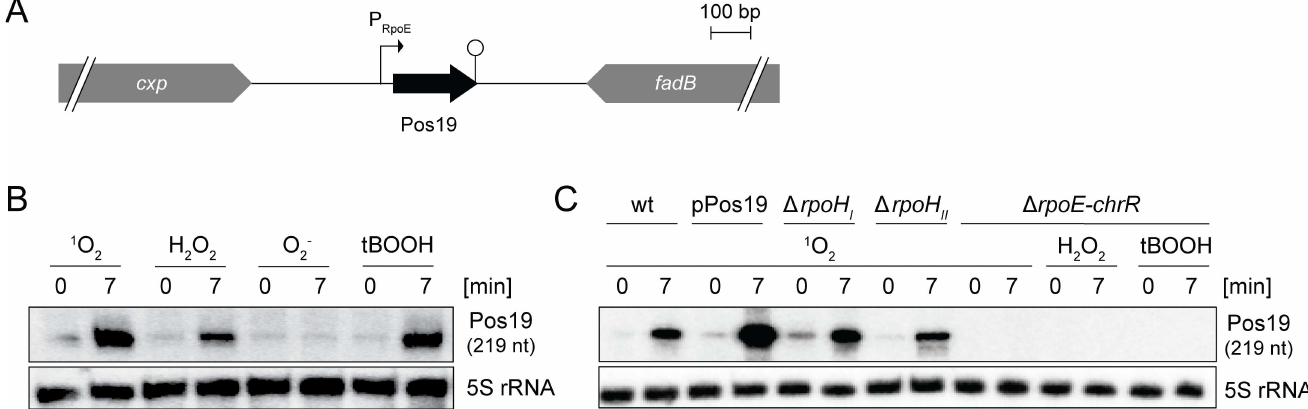
Fig 1. Pos19 is induced by singlet oxygen and peroxides. (A) Graphical representation of the Pos19 locus in R . sphaeroides wild-type strain 2.4.1. The pos19 gene is located on chromosome 2 between cxp and fadB . The conserved RpoE-dependent promoter (P RpoE ) and the Rho-independent terminator (lollipopstructure) are indicated. (B) Northern blot for stress-dependent Pos19 induction. R . sphaeroides wild-type 2.4.1 cultures were treated with stress-generating chemicals and samples collectedat time points 0 and 7 min. Singlet oxygen ( 1 O 2 ) was generated by the additionof 0.2 μ M methylene blue in the presence of high light intensities (800 W m -2 ). Hydrogenperoxide (H 2 O 2 ) and tert -butyl hydroperoxide (tBOOH) were added in final concentrations of 1 mM and 300 μ M, respectively. 250 μ M of paraquat(PQ) were used for the generation of superoxide radicals (O 2 – ). 5S rRNA was probed as loadingcontrol. (C) Northern blot for RpoE-dependent Pos19 expression. The R . sphaeroides wild-type(wt), the Pos19 over- expression (pPos19), RpoH I and RpoH II mutant strains, as well as a strain lacking the rpoE-chrR locus (TF18), were treated with the indicatedstress- generating chemicals as describedabove. Samples were collectedat the indicated time points. 5S rRNA was probed as loadingcontrol.